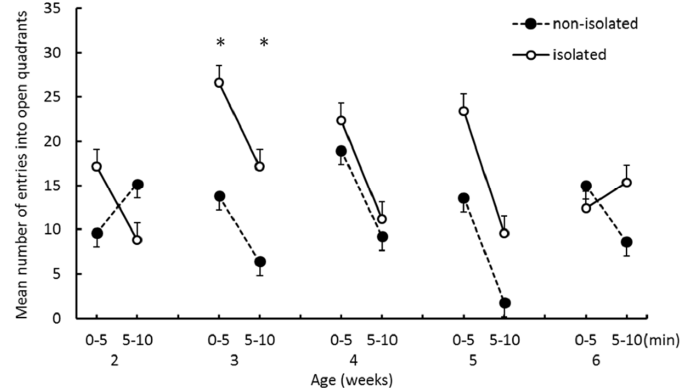
Figure 4. The mean number of entries into closed quadrants during the EZM test. Error bars indicate the standard error.